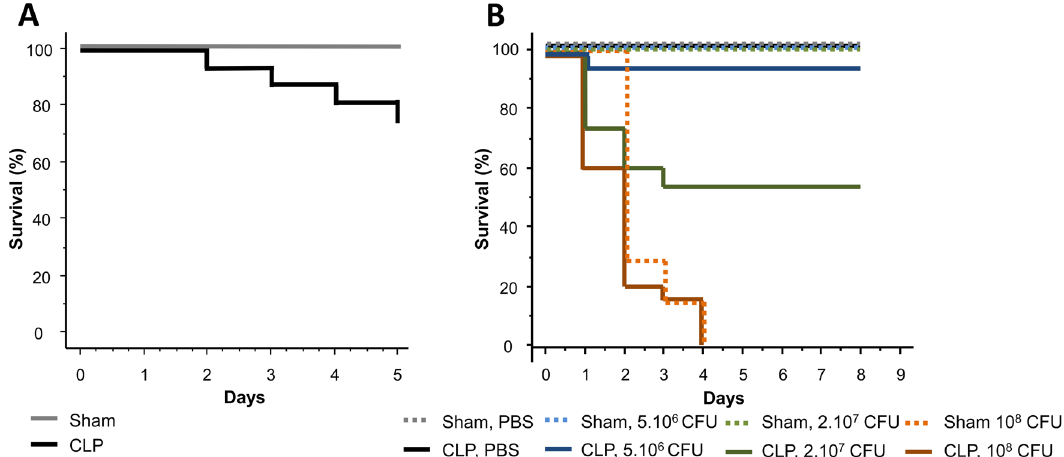
Fig 5. Survival after bacterial challenges. (A) During the first septic assault, after CLP and prior to P . aeruginosa instillation (D5), 28% of CLP-operated mice (22/80) died. During this period, 100% of Sham-operated mice (n = 29) survived. (B) At D5 post CLP, mice were challenged with an intratracheal administration of P . aeruginosa . Since CLP mice died until 5 days, final survival data were given by subtracting lethality induced by CLP during the first assault. So we considered the remaining living mice as 100% for this second survival study. Either PBS (Sham n = 6, CLP n = 10) or Pseudomonas aeruginosa were instilled. For bacterial challenge, three doses were administered: 5.10 6 CFU (Sham n = 6 and CLP n = 15), 2.10 7 CFU (Sham n = 10 and CLP n = 17) and 10 8 CFU (Sham n = 7 and CLP n = 20). Results are expressed as Kaplan Meier survival curves. p < 0.05 were considered statistically